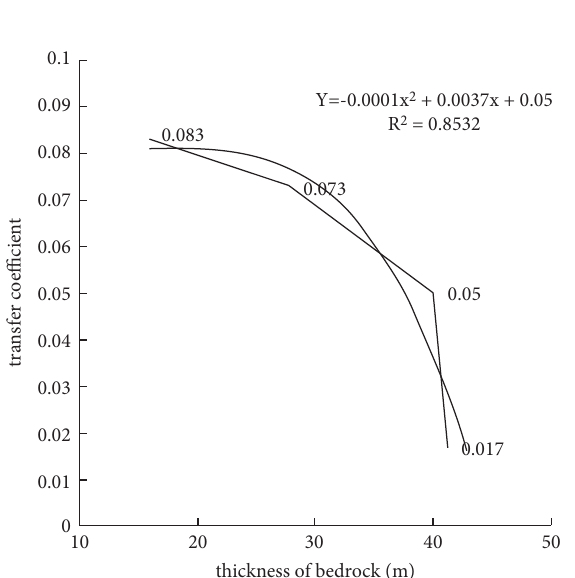
Figure 1: The regression curve of bedrock thickness and transfer